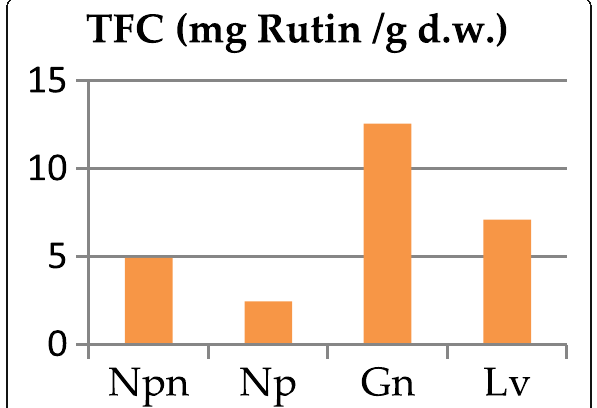
Fig. 6 Total flavonoid content (TFC) of Amaryllidaceae species